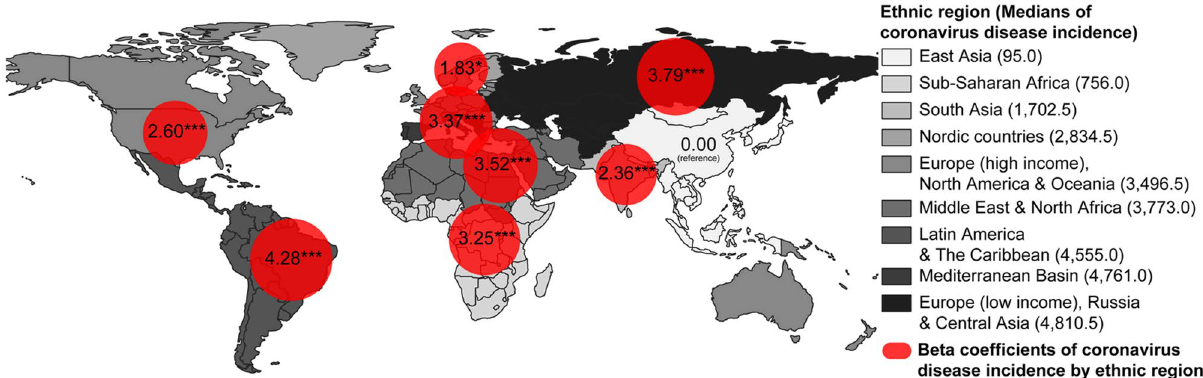
Figure 2. Medians and beta coefficients of COVID-19 incidence by ethnic region in 107 northern hemisphere countries. The size of red circle indicates the beta coefficients, which were determined by using multiple linear